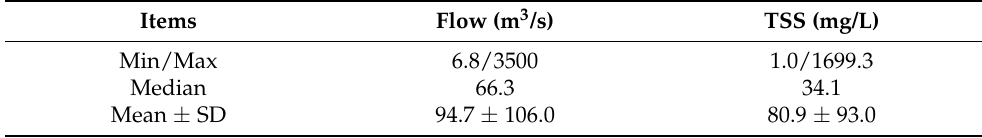
Table 1. Statistical summary of the observed river flow and total suspended sediment (TSS) concentration at the Kon Tum station (2000–2018). Min/Max: minimum and maximum values; SD: standard